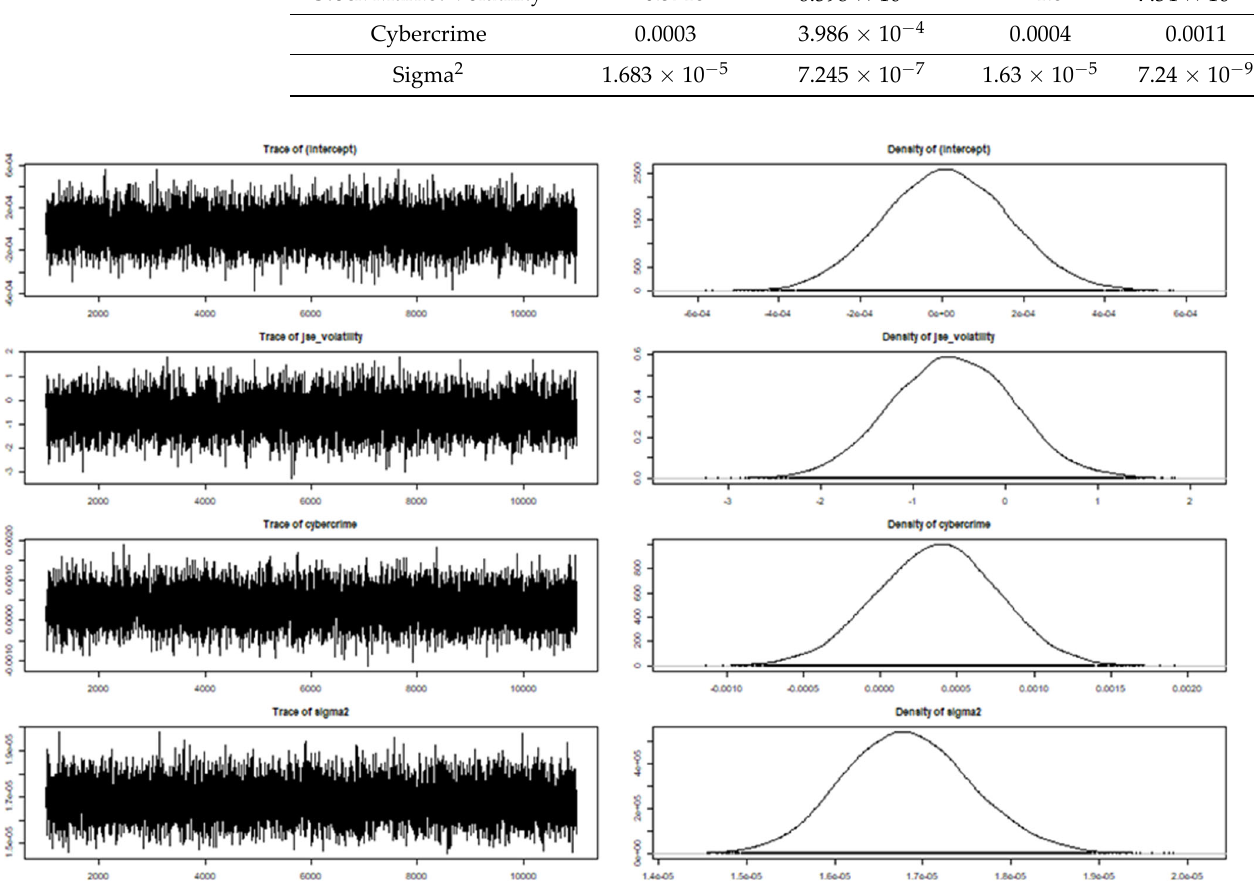
Figure 10. Posterior distribution of the variables with return on Tether as dependent variable